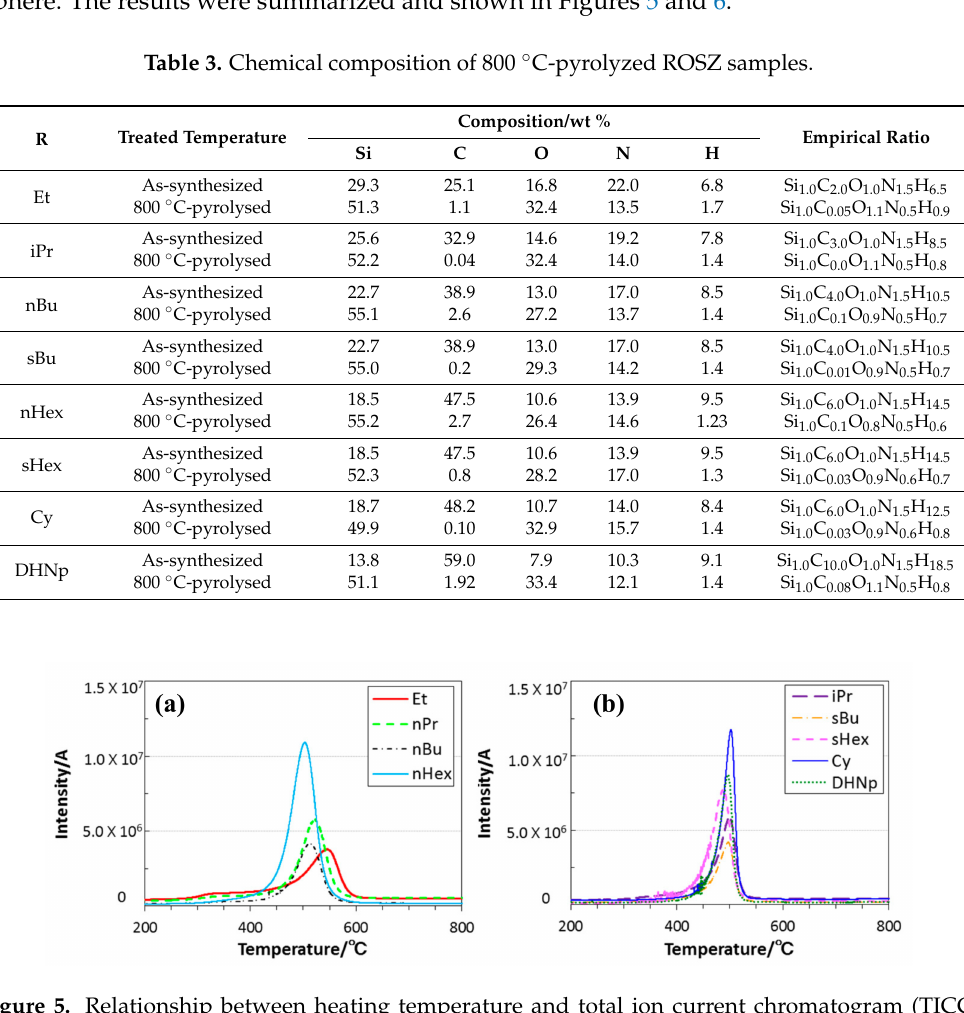
Figure 5. Relationship between heating temperature and total ion current chromatogram (TICC) detected for the gaseous species formed in-situ. ROSZ sample polymers having ( a ) primary alkyl group; and ( b ) secondary alkyl